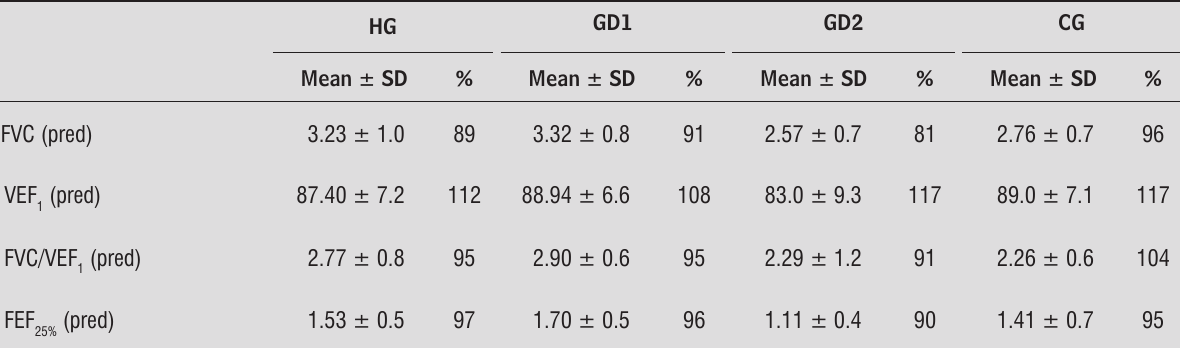
Table 2 - Spirometric data